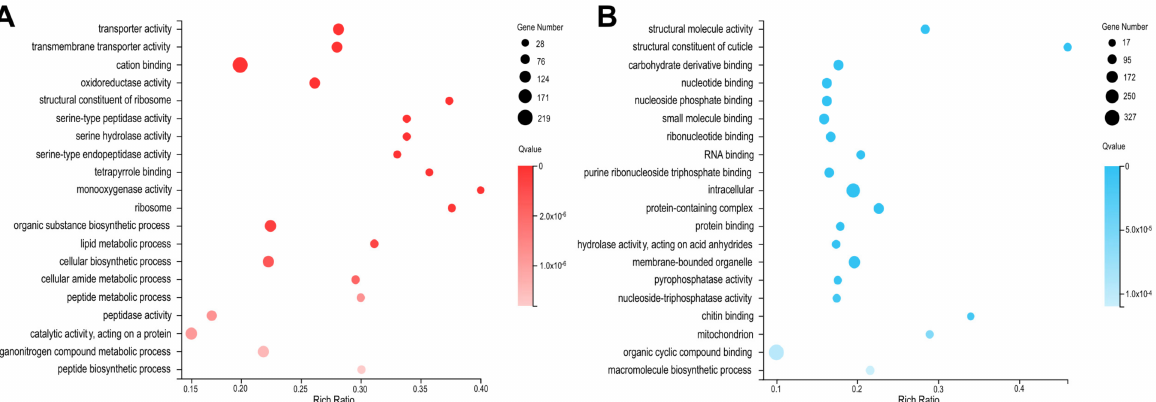
Figure 5. GO annotations of DEGs between WT and KO-METTL4 mutant. Functional categories of DEGs were analyzed by Gene Ontology (GO). The images exhibited top20 statistics of up-DEGs ( A ) and down-DEGs ( B ) on GO annotations.